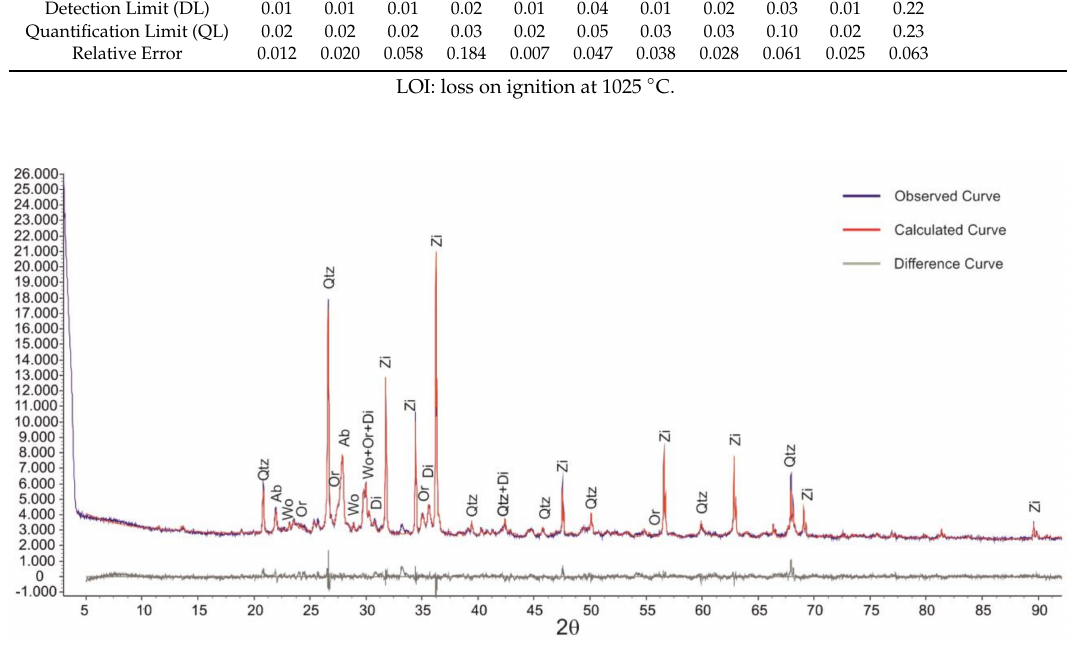
Figure 2. X-ray di ff raction (XRD) pattern of MPC2 (and Rietveld refinement). Abbrv.: Qtz—quartz; Ab—Albite; Wo—wollastonite; Or—orthoclase; Di—diopside; Zi—zincite (Internal Standard). Table 2. Mineralogical composition (wt %) of selected brick MPC2 (Qtz: quartz; Wo: wollastonite; Or: orthoclase; Ab: albite; Di: diopside; An: anorthite; Amor: amorphous phase). Rexp, Rwp, and GOF are numerical indicators of how well the Rietveld model was refined. Rwp, residual of least-squares refinement (weighted), which must be improved in refinement (with common sense); Rexp evaluates data quality; and GOF, goodness of fit